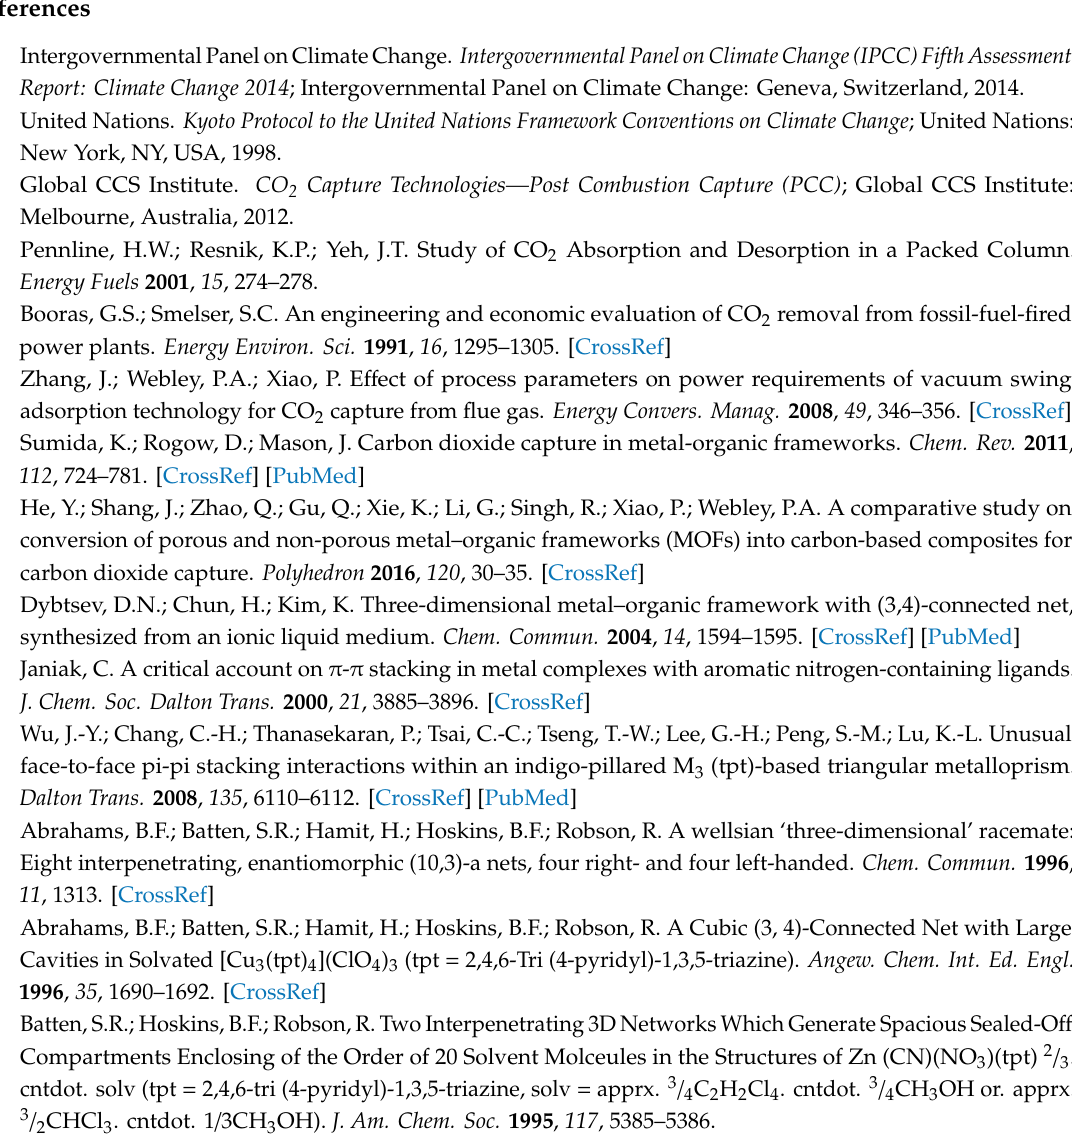
MOF, Figure S3: Comparison of: (top) Simulated powder X-ray di ff raction pattern based upon single crystal analysis; (bottom) Experimental powder X-ray di ff raction patterns for three di ff erent samples, Figure S4: TGA and DSC of Cu(tpt)BF4 · 3 H 2 O, Figure S5: Calculated heat capacity across the full DSC range of 40 ◦ C–290 ◦ C, Figure S6: 4 Adsorption isotherm for N 2 on Cu(tpt)BF4 · 3 H 2 O at 77 K, Figure S7: BET plot from Rouquerol transform data for 4 adsorption of N 2 on Cu(tpt)BF 4 · 3 H 2 O at 77 K, Figure S8: Selected area (0.04 ≤ P / Po ≤ 0.11) BET fit for adsorption of 4 N 2 on Cu(tpt)BF4 · 3 H 2 O at 77 K, Figure S9: Adsorption isotherm for CO 2 on Cu(tpt)BF4 · 3 4 to Langmuir adsorption